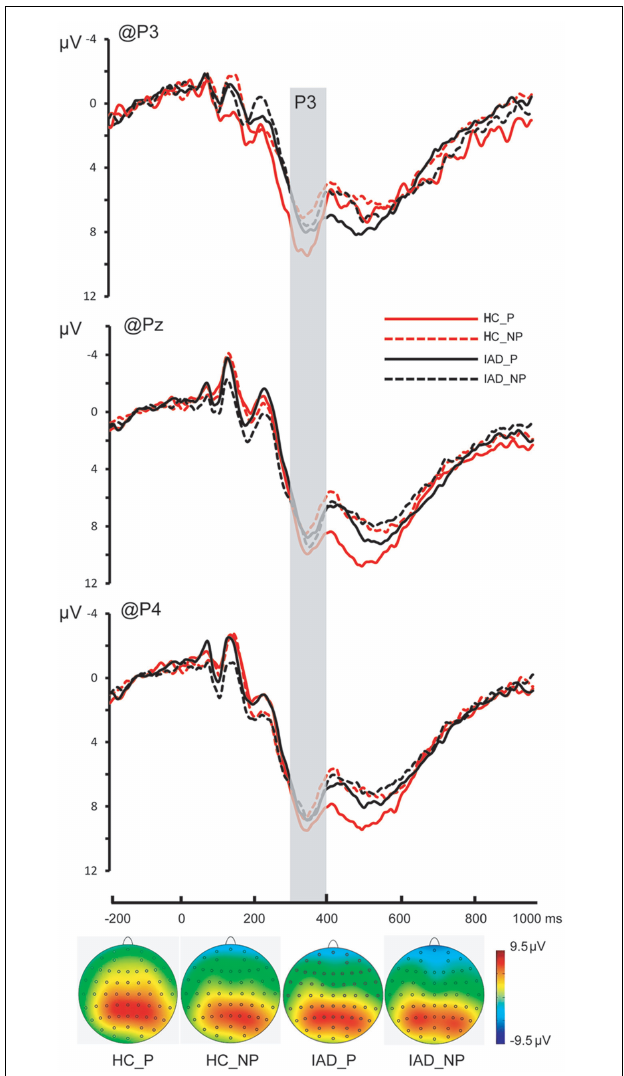
FIGURE 3 | The Grand average on P3, Pz, and P4; the topography of P3 in all four conditions (the time window of the topography was corresponding to the gray square covered